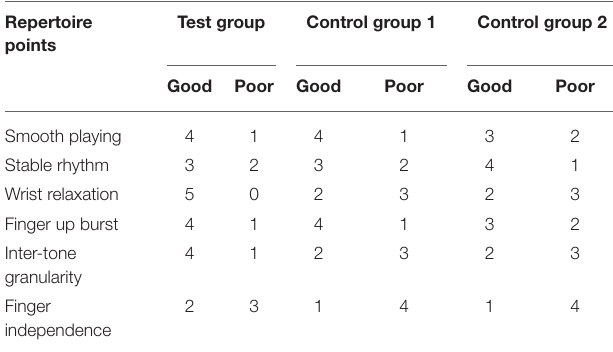
TABLE 6 | Comparison of piano teaching effects among groups in grade